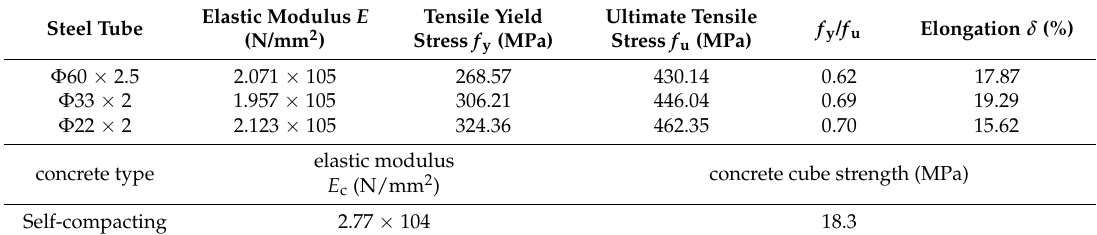
Table 2. Material properties.